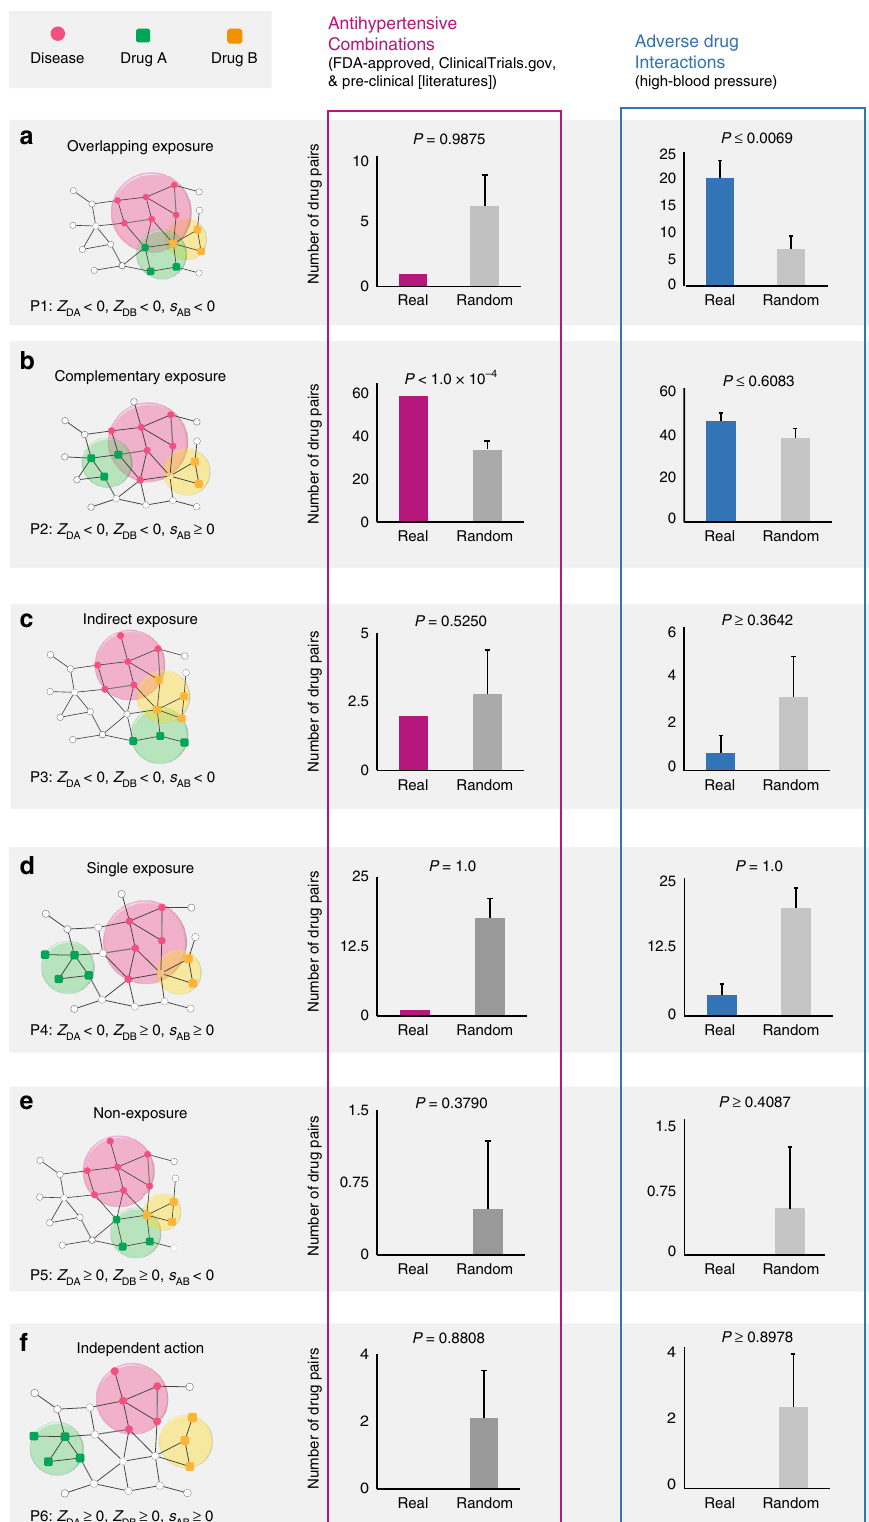
Two separated drug – target modules that overlap individually with the disease module (P2 in Fig. 2b); (c) Indirect Exposure: One drug – target module of two overlapping drug – target modules overlaps with the disease module (P3 in Fig. 2c); (d) Single Expo- sure: One drug – target module separated from another drug – target